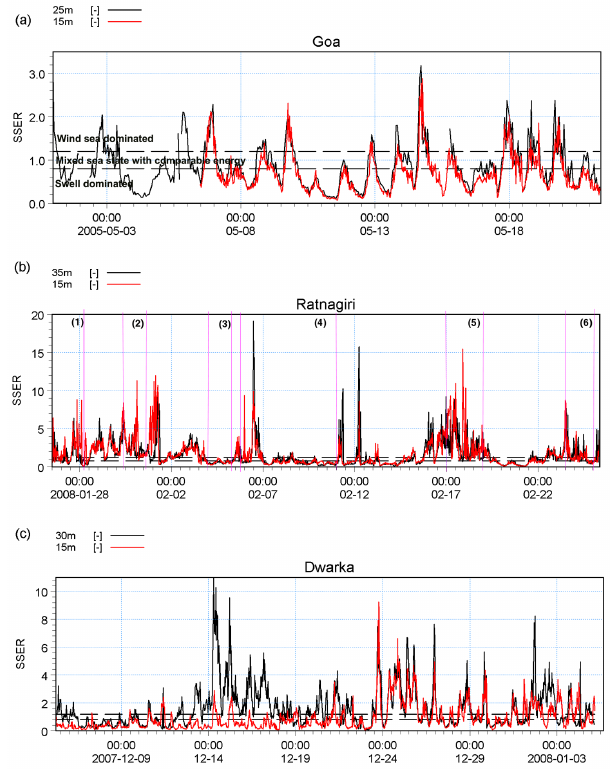
Fig. 4. SSER of wind sea, mixed sea and swell: (a) 15m and 25m depths off Goa, (b) 15m and 35m depths off Ratnagiri; vertical lines from 1 to 6 refer to shamal events, and (c) 15m and 30m depths off Dwarka.